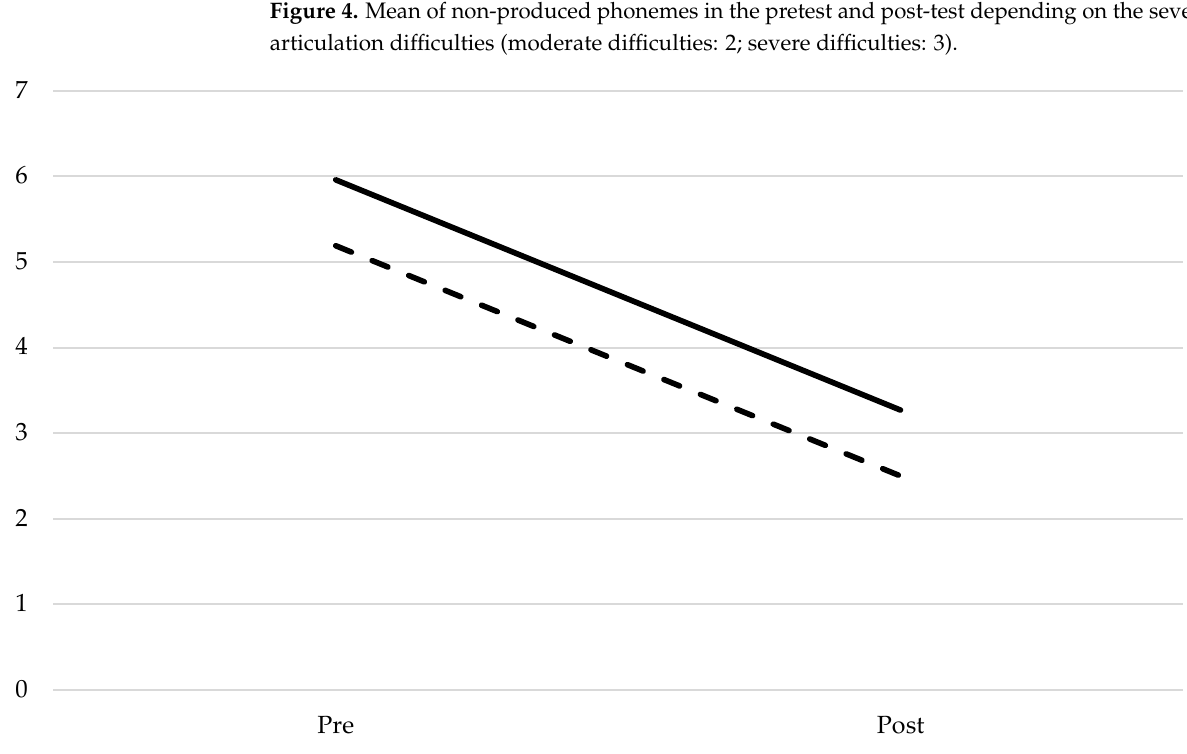
Figure 5. Mean of pre- and post-test non-produced sounds for the experimental and control groups.